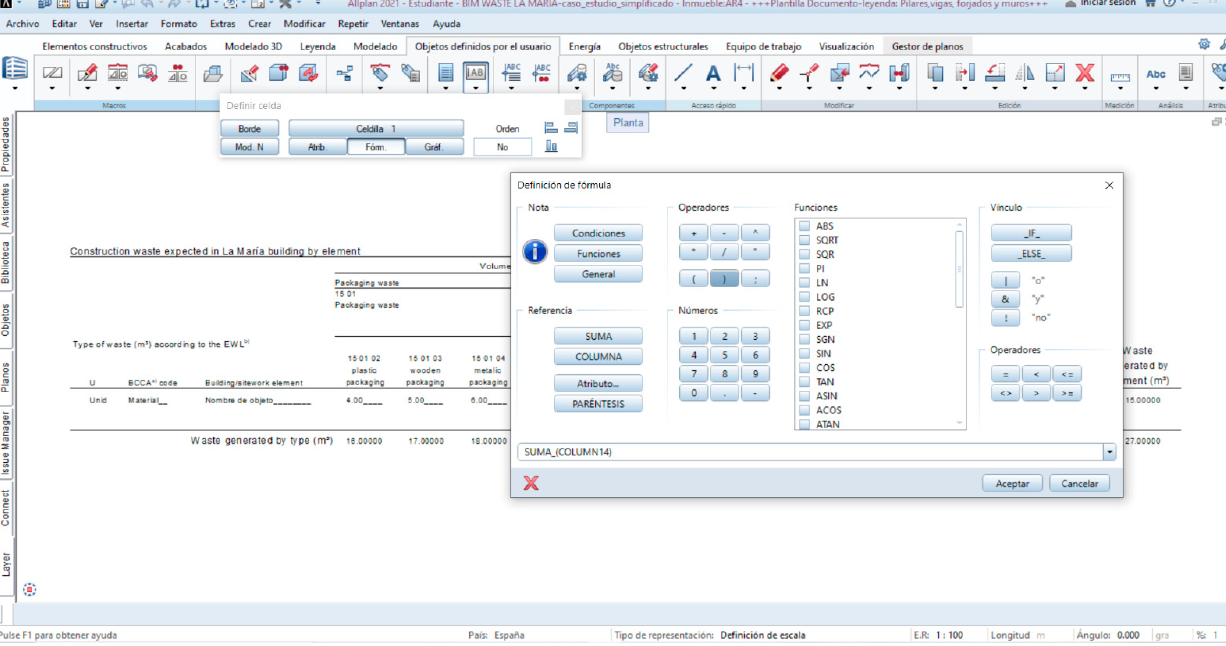
Figure 5. Report design tool in Allplan 2021.